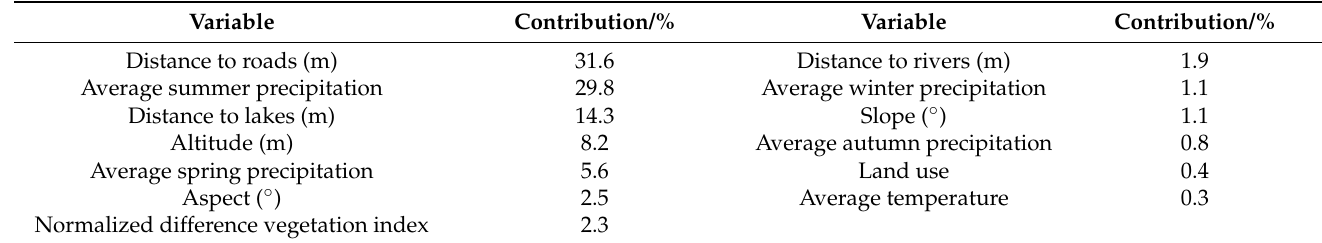
Figure 5. The importance of environmental variables evaluated by Jackknife testing. Table 3. Contributions of the environmental variables to the MaxEnt